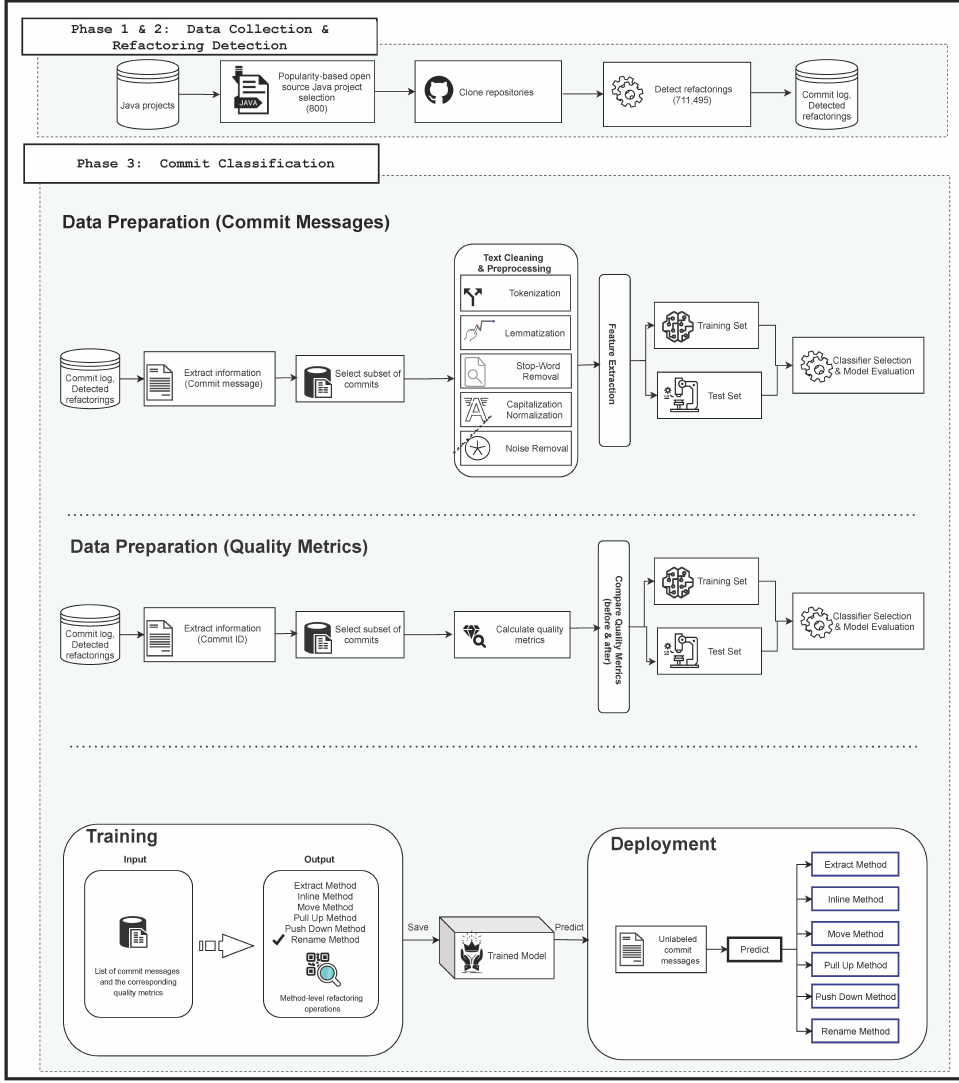
Figure 1. Overall framework.